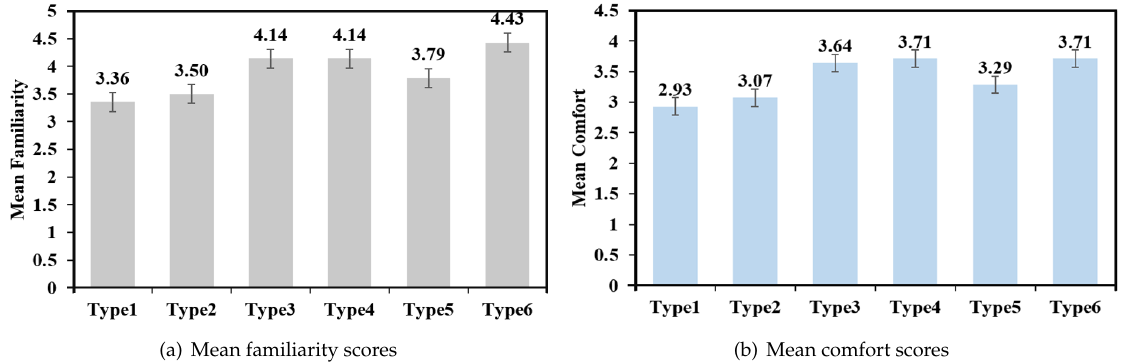
Figure 14. Mean familiarity scores ( a ) and mean comfort scores ( b ) of 6 different placement